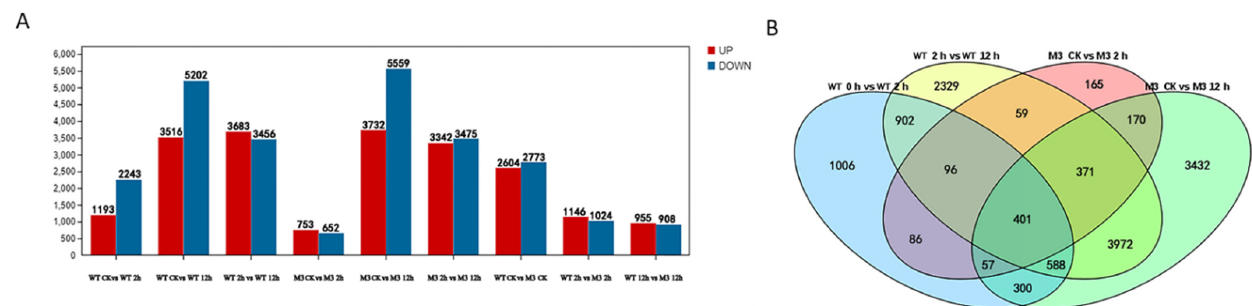
Figure 3. Profiles of gene expression in WT and M3 plants exposed to low-temperature stress for 2 h and 12 h. ( A ) The total number of upregulated and downregulated genes in WT and M3 plants under low-temperature stress treatment. ( B ) Venn diagram describing overlaps among DEGs in WT and M3 plants under low-temperature stress treatment.